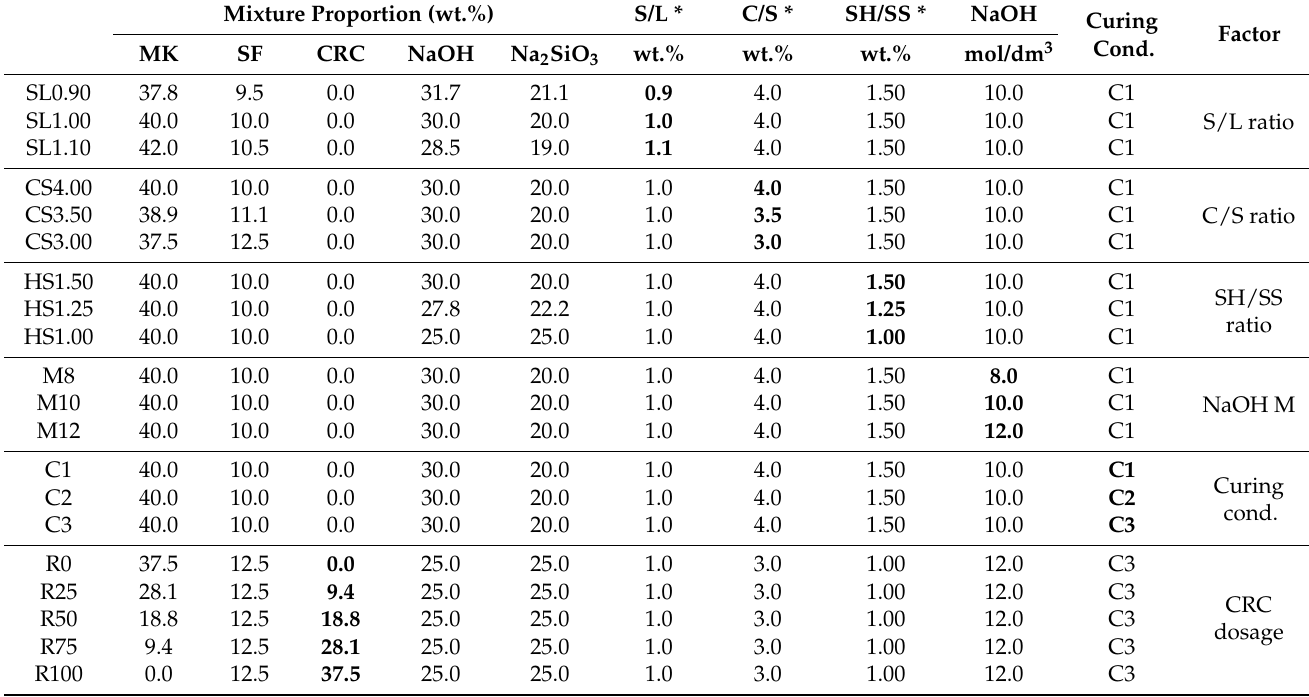
Table 1. Experimental plan: Binders’ mix design and variables